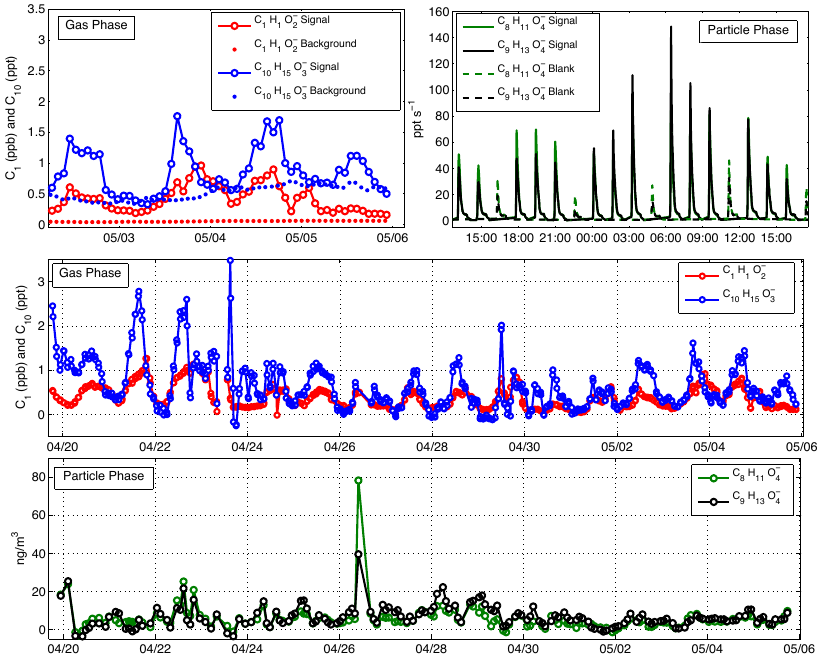
Fig. 10. An overview of the FIGAERO performance during a field campaign at Hyytiälä, Finland, a boreal forest site. Top (left): example time series of both the total signal (open circles) and measured background (dots), in mixing ratio equivalent units, for the deprotonated ions of two compounds detected in the gas phase, HCOOH (formic acid) and C 10 H 16 O 3 (pinonic acid or other monoterpene derived acid). Significant signal above the background is measured, allowing routine measurement of sub ppt concentrations. Top (right): raw thermal desorption signals (solid lines) and filter blank determinations (dashed lines) for two major particle components in the FIGAERO HRToF- CIMS spectra during measurements at the Hyytiälä field site. Filter blank desorptions are significantly lower than those containing ambient particles, allowing measurement of individual components present in particles at 1ngm − 3 concentrations. Middle: a time series of the background corrected C 1 and C 10 compounds displayed in the upper left panel, exhibiting a semi-regular diurnal pattern. Bottom: a time series of filter blank corrected particle composition. Evident is the spike in concentrations on the 26th when a sawmill plume was intercepted at the field site, otherwise the time series shows the influence of regional transport, rain events, and other meteorological